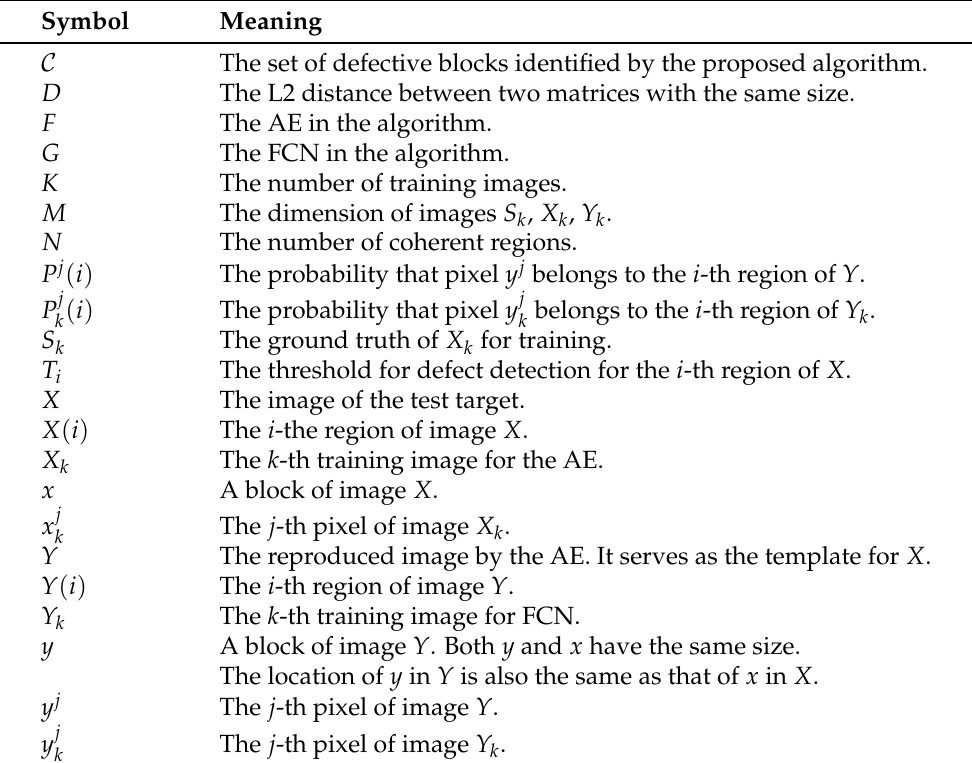
Table 1. A list of frequently used symbols in this